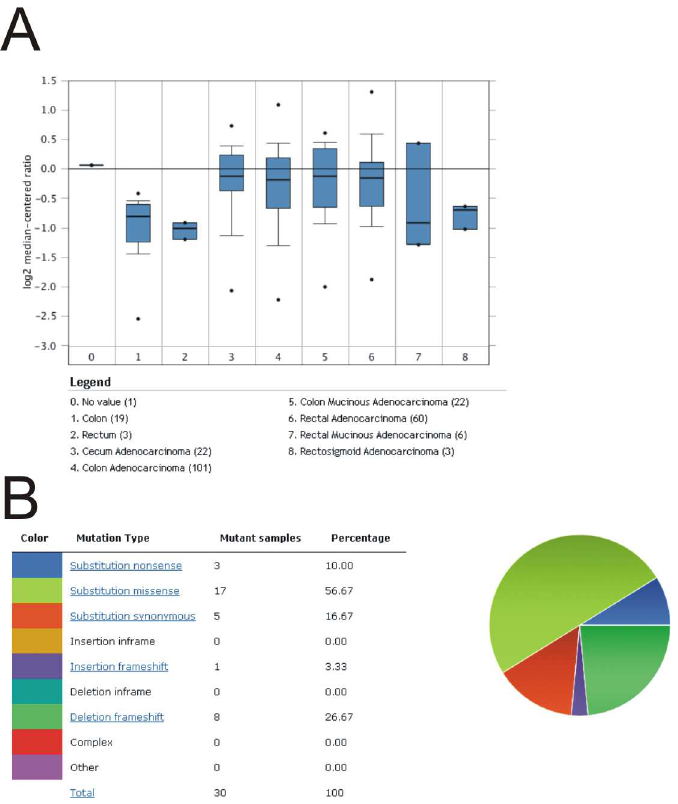
Fig 3. Bioinformatic analysis of RINT1 expression and mutation spectrain human colorectal cancers. Information regardingrelative expressionof RINT1 in normal colorectaltissue and colorectalcancers was extracted from the ONCOMINE database(A). Analysis of the nature of somatic mutations in RINT1 found in colorectalcancers was extracted from the COSMIC